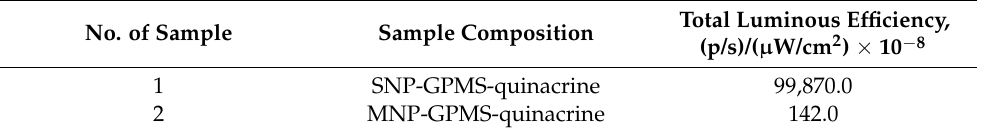
Figure 6. Particle size distribution of SNPs with quinacrine immobilized on a glycidyl spacer. Table 3. Measured values of luminous efficiency of fluorescent radiation of samples.